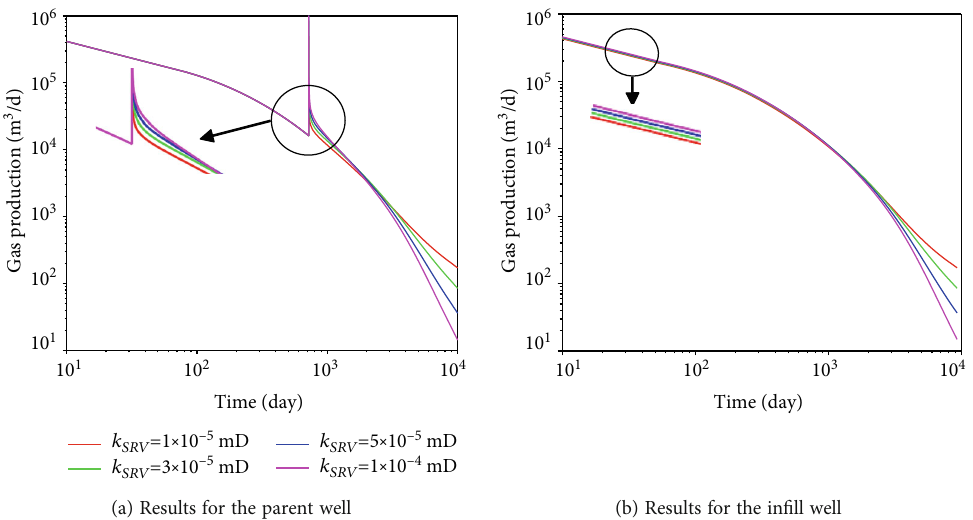
Figure 9: The e ff ects of the SRV permeability on the gas production of both parent and in fi ll wells.